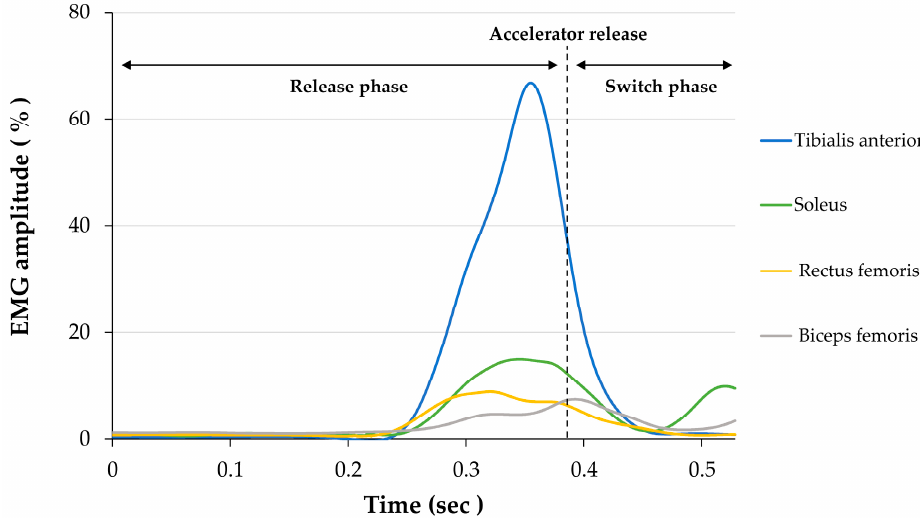
Figure 3. Representative case of the normalized EMG waveforms. Table 3. Electromyography amplitude and co-activation duration during emergency braking.